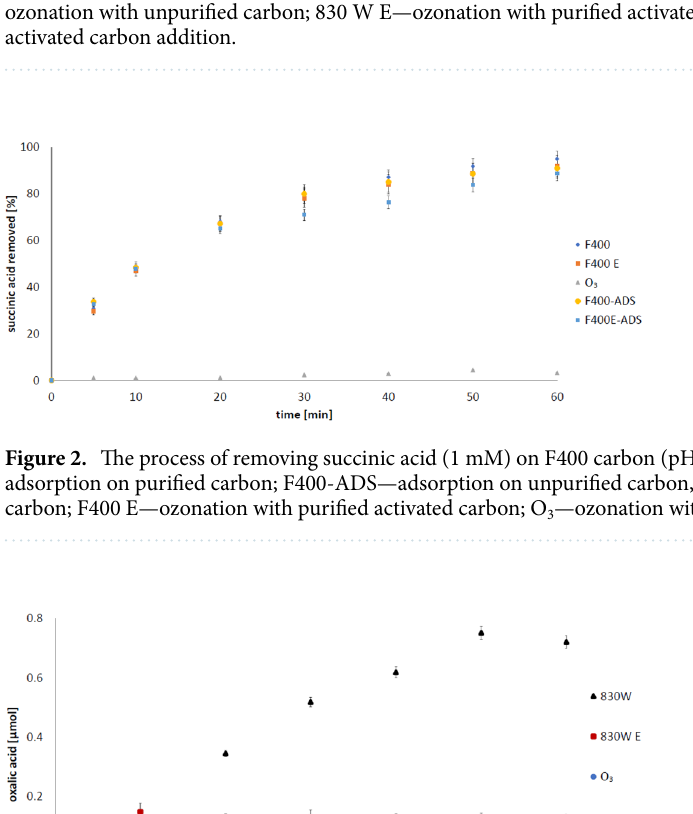
Figure 1. The process of removing succinic acid (1 mM) on 830 W carbon (pH 2.5; 2 g/200 ml): 830 W E‑ADS—adsorption on purified carbon; 830 W‑ADS—adsorption on unpurified carbon, 830 W—